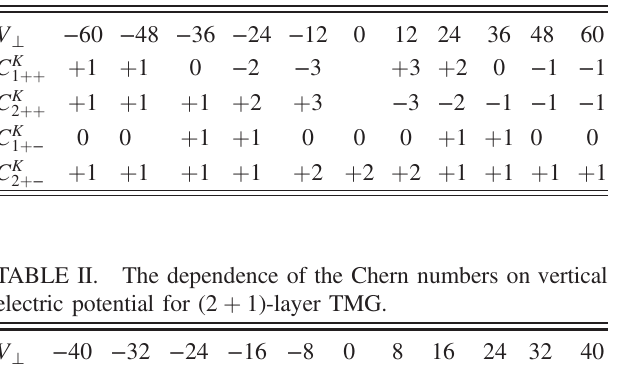
TABLE I. The dependence of the Chern numbers on vertical electric potential for ( 2 þ 2 )-layer TMG.